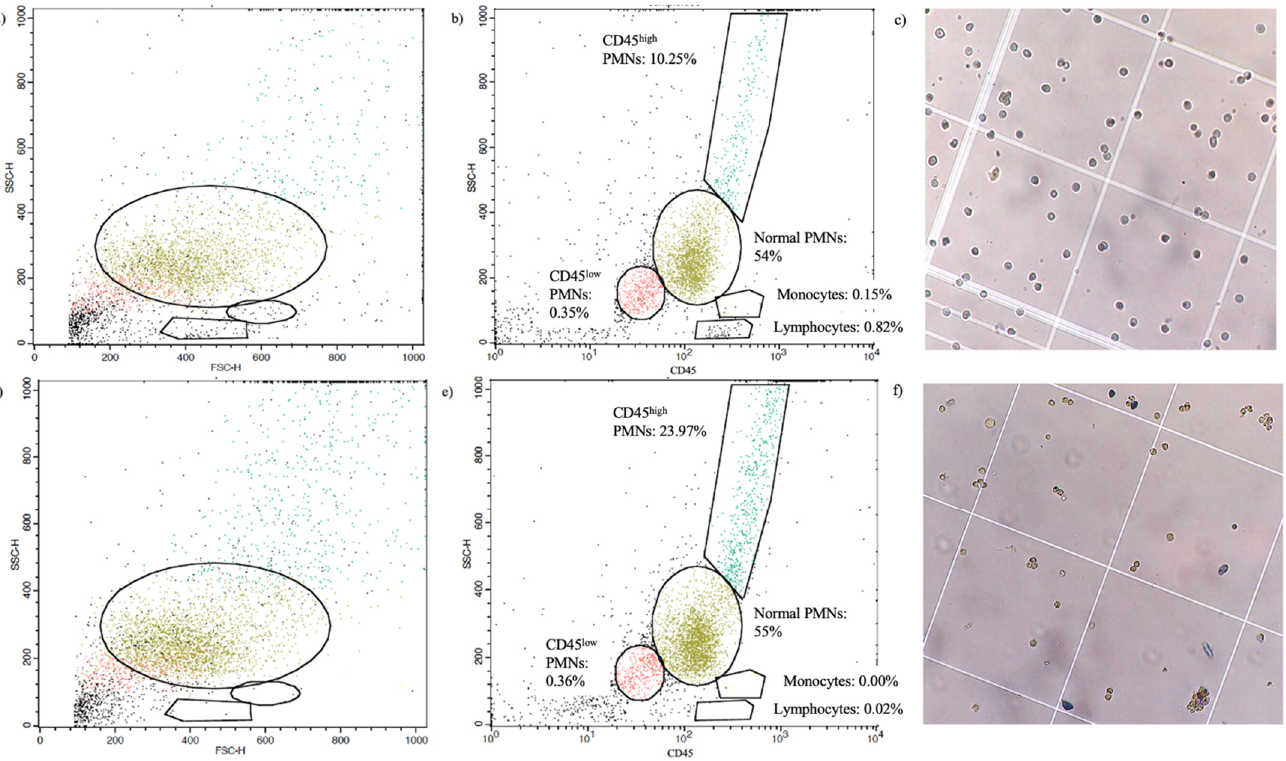
Figure 1. Identification of different cell populations using flow cytometry double-gating strategy in mixed tear PMNs ( a – c ) and MACS-isolated PMNs ( d – f ). ( a , d ) Side scatter versus forward scatter dot plots identifying leukocyte populations based on their size and cytoplasmic complexity. ( b , e ) Side scatter versus CD45 fluorescence (pan leukocyte marker) dot plot with CD45 + cells. Different cell populations have been identified along with their relative percentage. ( c , f ) Light microscopy images of mixed and MACS-isolated tear PMNs. Cell aggregates can be observed following isolation by the MACS column.